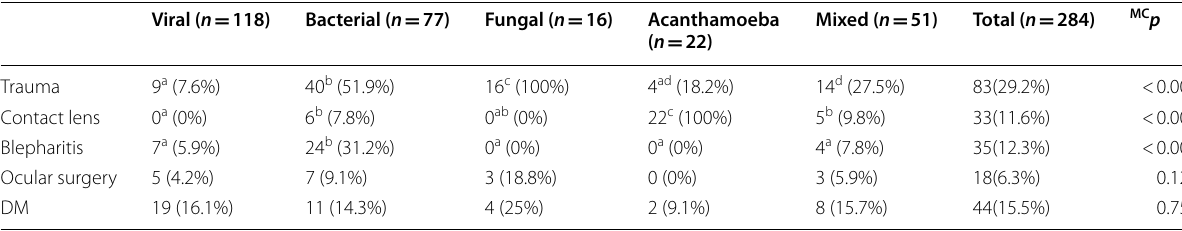
MC Monte carlo, p : p -value for comparing between the studied groups * Statistically significant at p 0.05 Numbers with different letters are significant ≤